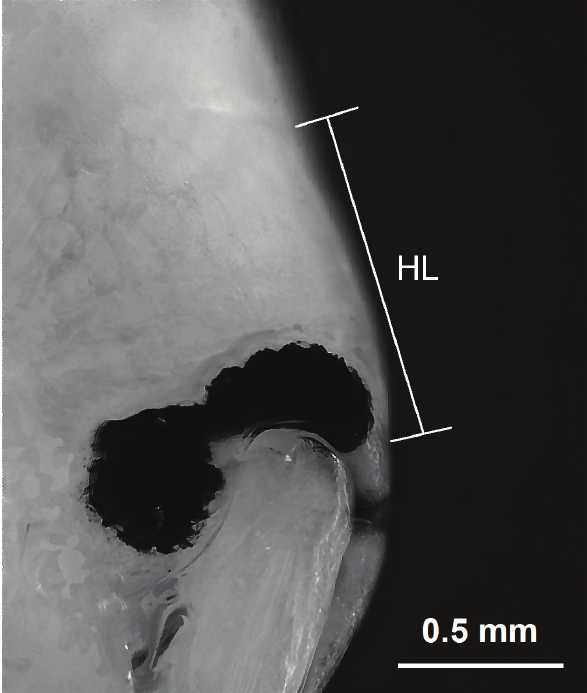
Figure 2. Head length (HL) used as a reference parameter in Quadrivisio lutzi .